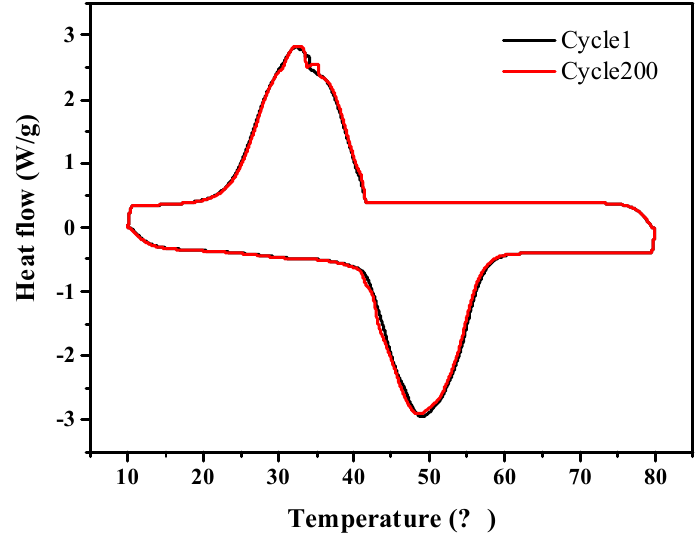
Figure 10. Heating/cooling stability of A-CMK-3 based PCM composite.